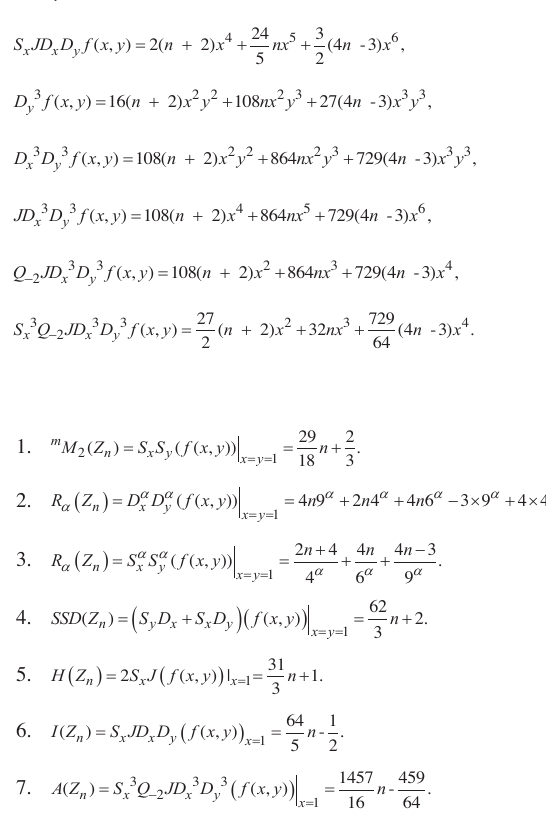
Take another benzenoid system in which hexagons are arranged to form a rhombic , in which there are n rows of n hexagons as given in Figure 4. Then it has shape n R 2 ( 2) n n  vertices and 2 3 4 1 n n   edges. On the similar lines we partition edges on the basis of degrees of endpoints. Clearly, all vertices are either of 2 nd or 3rd degree.   2,2 E appear only on the four corners of the rhomb, so 6 E appear in pairs along the E      . Edges   2,3 u vn boundary except the corners where they are single. So we obtain